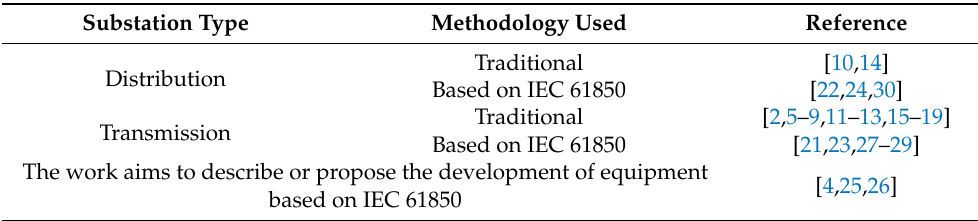
Table 1. Works found in the literature on busbar protection.